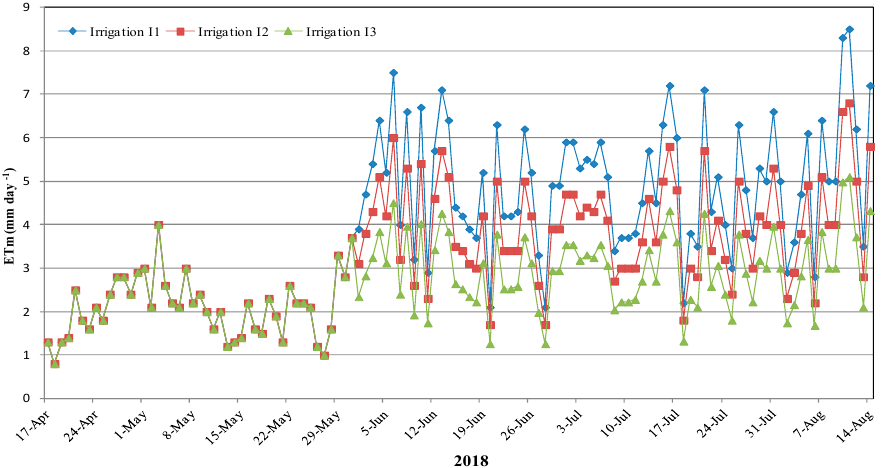
Figure 4. Daily fiber hemp evapotranspiration under the three irrigation regimes in 2018.